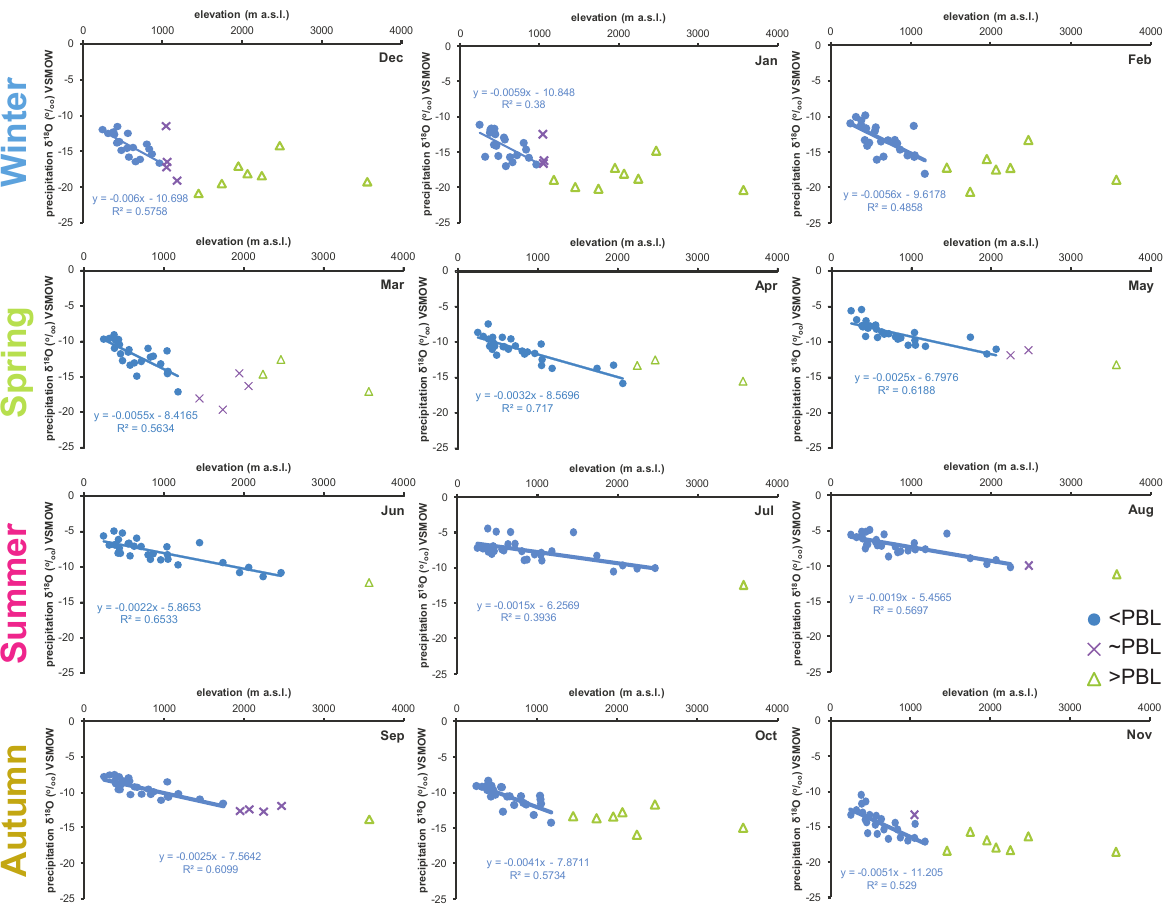
Fig. 2. Monthly amount-weighted stable oxygen isotope composition of precipitation over Switzerland and its border zone. Blue dots repre- sent stations that were always below the planetary boundary layer (PBL), green triangles represent stations that were always above the PBL, while purple crosses represent stations that were occasionally above the PBL during the 1995–2000 period. Regression equations fitted to the stations below the PBL are given for each